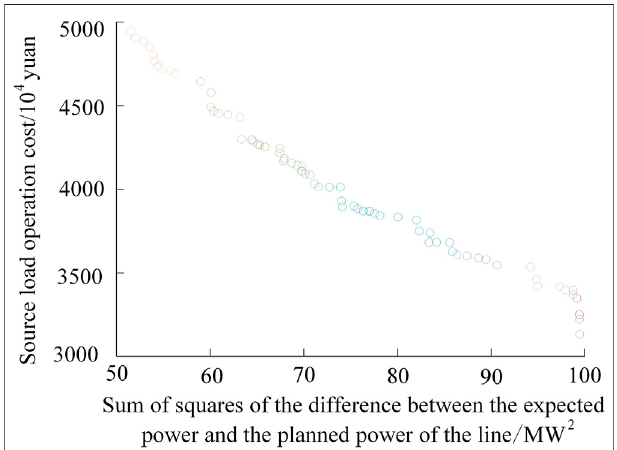
FIGURE 10 | Different algorithms for the best